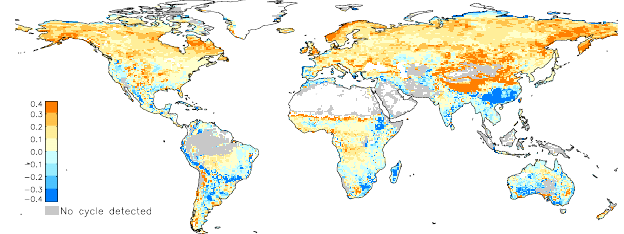
Fig. 4. Difference between the correlation maps for the new phe- nology and the current phenology.